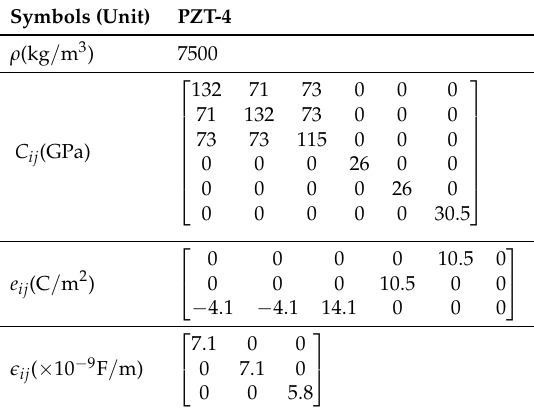
Table 1. Properties of the piezoelectric PZT-4 [35] at z = 0.